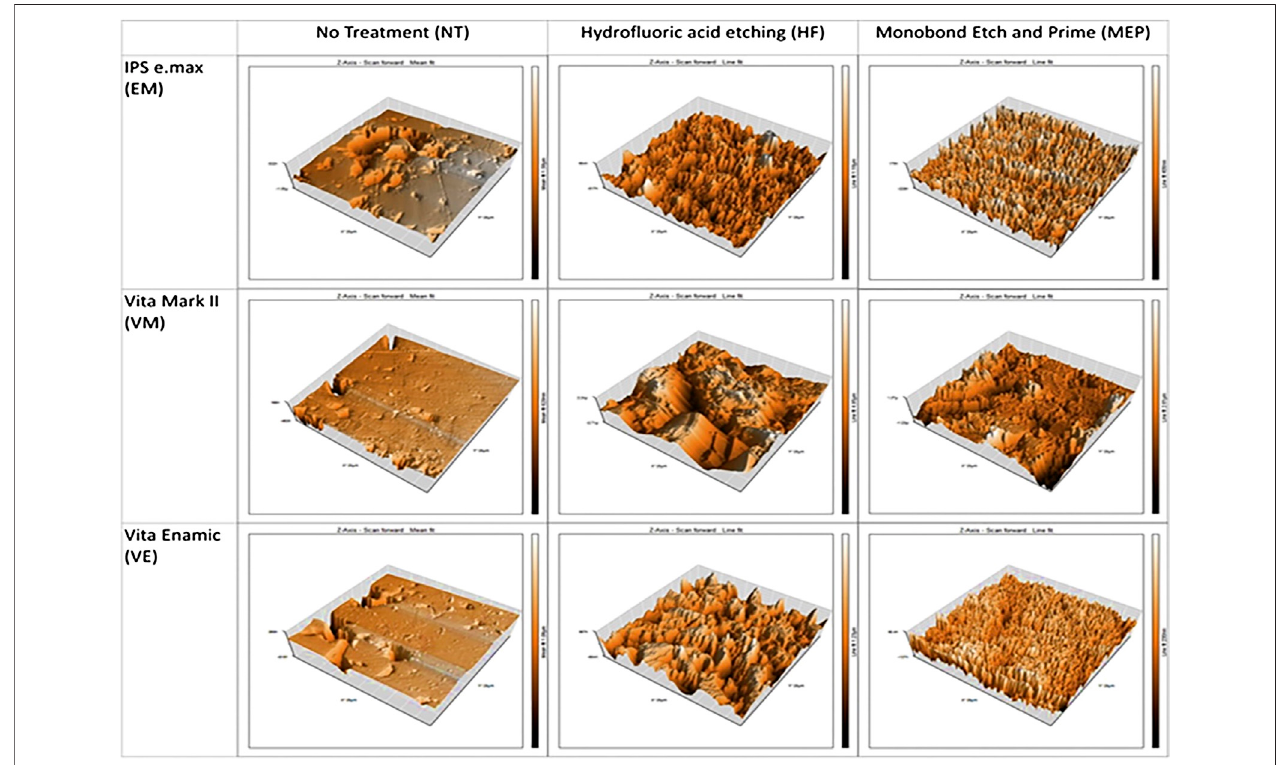
FIGURE 7 | Micrographs of the materials tested after no treatment (NT), hydro fl uoric acid etching/Monobond Plus (HFMP) or self-etching ceramic primer Monobond Etch and Prime (MEP) pretreatment.